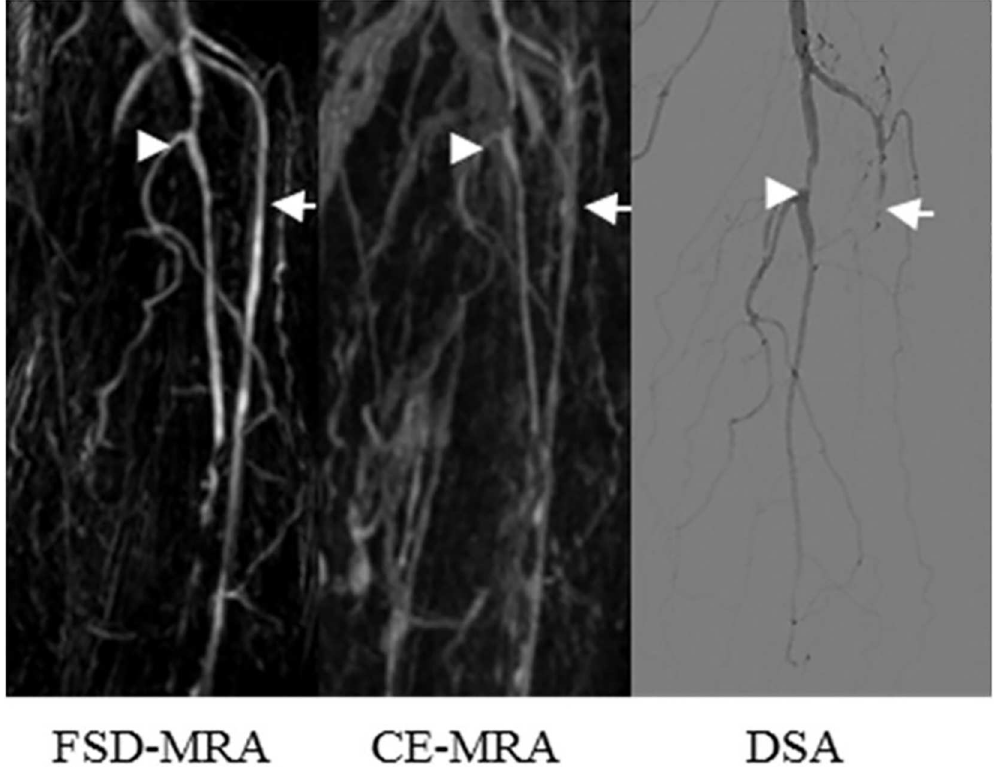
Fig 3. Images from an 81-year-old female patient with a 20-yearhistory of diabetes suffered intermittent claudication for 1 year without rest pain. Consistent with CE-MRA and DSA, FSD-MRA revealedan occlusive lesion on the left posterior tibial artery (white arrowheads) and multiple significantstenosis lesionson the left tibiofibulartrunk and left fibular artery. Venous contamination mimicked the left anterior tibial artery in FSD-MRA and CE-MRA, however an occlusionwas apparentat that locationin DSA (white arrow).